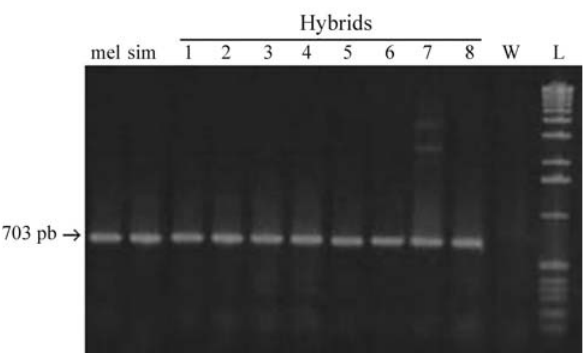
Figure 2 - The Bari-1 transposable element PCR products corresponding to the internal segment with 703 bp in D. simulans , D. melanogaster and hybrid strains visualized in 1% agarose gel. Lanes are as follows: mel, D. melanogaster IN(1)AB; sim, D. simulans C167.4; 1-8: SM 1 to SM 8 hybrid strains; W, water; L, 1 kb DNA ladder size marker (GIBCO-BRL).